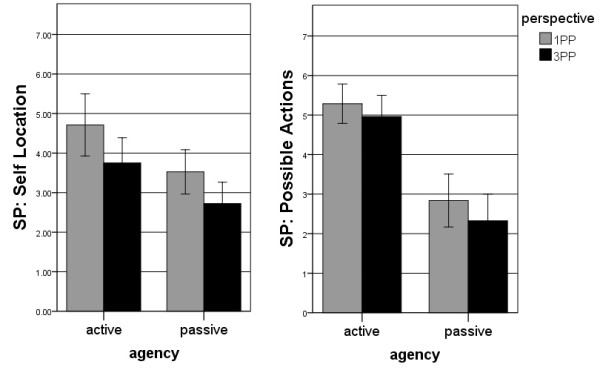
SP rating. Depicted are the means (with SE) in the self-location rating (Figure 2a) and in the possible actions rating (Figure 2b) on an 8-point scale. This is broken down for the four different conditions: 1PP-active, 3PP-active, 1PP-passive and 3PP-passive. The subjects indicated the greatest SP experience in 1PP-active, followed by 3PP-active, 1PP-passive and 3PP-passive in this order.